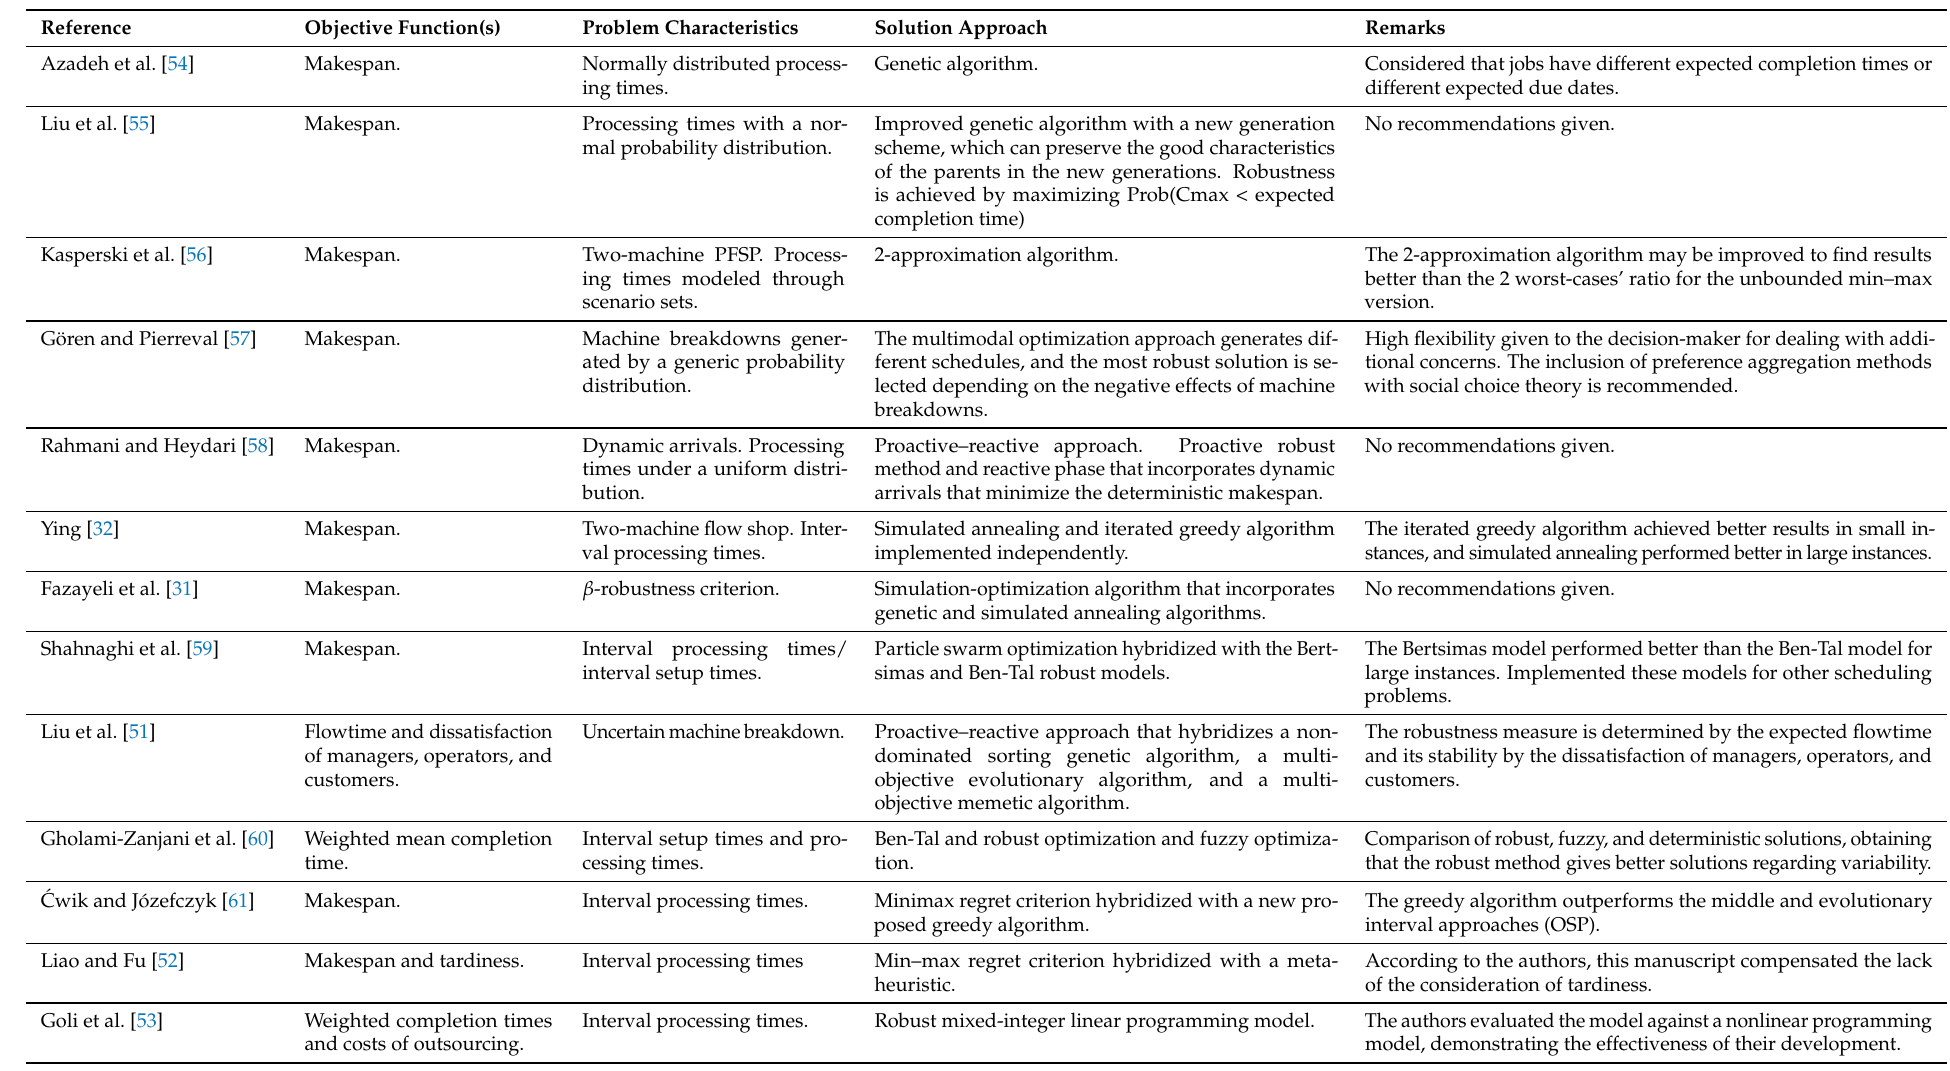
Table 1. Modeling approaches for the stochastic flow shop problem (SFSP) that address